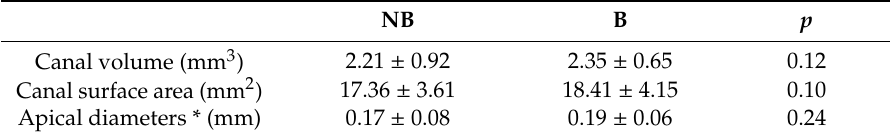
Table 1. Sample baseline characteristics in the no-brushing and brushing groups (mean ± STD). Statistical significance indicated by p < 0.05. *Apical diameters (mean ± STD) at 1 mm from the apical foramen. B = brushing group; NB = no-brushing group; STD = standard deviation. NB B p